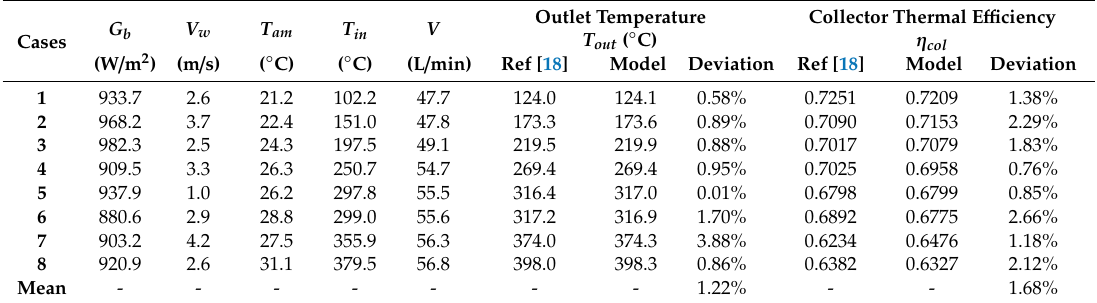
Table 2. Validation of the present model with experimental data from the Reference